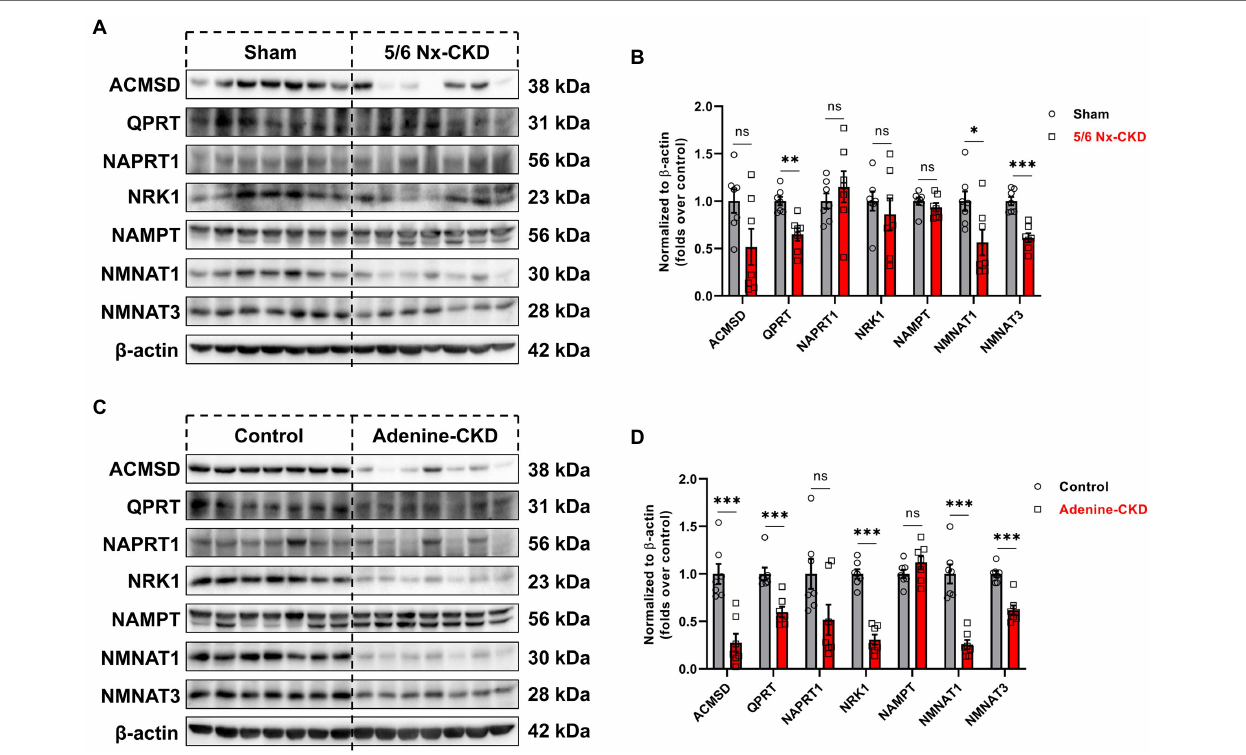
FIGURE 4 | The expression of related enzymes in the NAD + biosynthesis pathways. (A) Representative Western blot images of 7 enzymes in the kidney of sham and 5/6 Nx-induced CKD rats. (B) Densitometric analysis of 7 enzymes expression in the kidney of sham and 5/6 Nx-induced CKD rats, normalized to β -actin content. (C) Representative Western blot images of 7 enzymes in the kidney of control and adenine-induced CKD rats. (D) Densitometric analysis of 7 enzymes expression in the kidney of control and adenine-induced CKD rats, normalized to β -actin content. Data are presented as the means ± SEM, n = 7 rats per group ( * p < 0.05, ** p < 0.01, and *** p < 0.001 between the indicated two